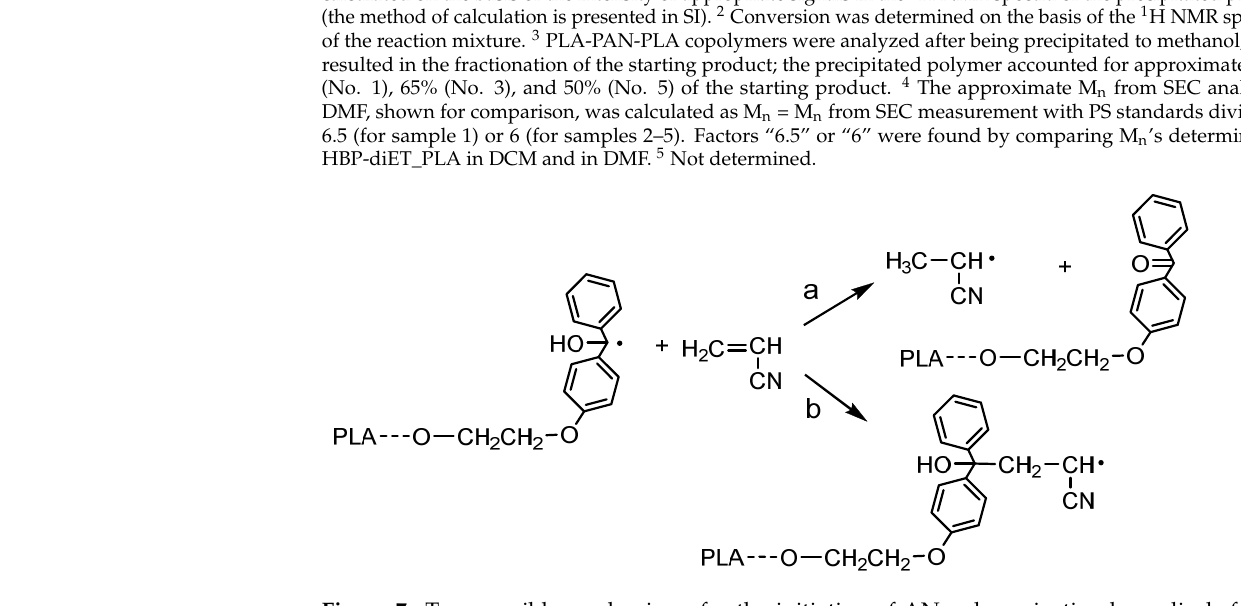
Figure 7. Two possible mechanisms for the initiation of AN polymerization by radicals formed from TPE-diET_PLA: ( a ) according to Braun vs. ( b ) proceeding by the addition of the (hyroxy)diphenylmethyl radical connected with the PLA chain to the AN monomer.